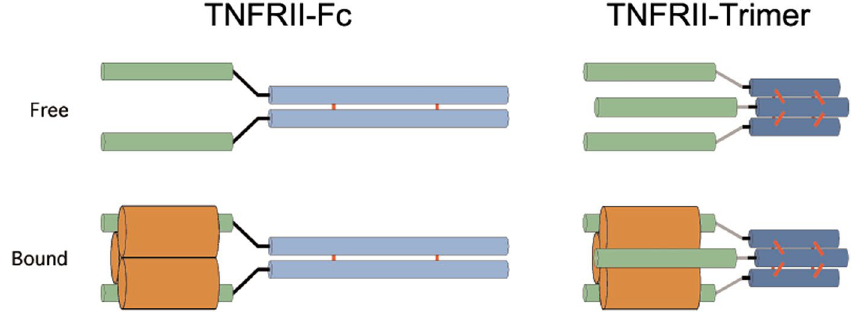
Figure 1. Schematic representation of the trimeric soluble human TNFRII receptor (TNFRII-Trimer) in comparison with dimeric immunoglobulin Fc fusion. On the left: Structural characteristics of a homodimeric soluble human TNFRII receptor-Fc fusion, Etanercept (TNFRII-Fc), in either ligand-free or -bound form as indicated. Domains labeled in green denote soluble TNFRII. Note that the Fc (labeled in light blue with inter-chain disulfide bonds in red) fusion protein is dimeric in structure. Given its 2-fold symmetry, the dimeric Fc fusion protein is bivalent and thus theoretically does not have the optimal conformation to bind to a homotrimeric ligand, TNF- α (labeled in brown), which has a 3-fold symmetry. On the right: Structure characteristics of the trimeric soluble human TNFRII receptor-C propeptide fusion. Given its 3-fold symmetry, the TNFRII-Trimer fusion protein is trivalent in nature, thus can perfectly dock to its trimeric ligand TNF- α . The C-propeptide of collagen capable of self trimerization is labeled in dark blue with inter-chain disulfide bonds labeled in